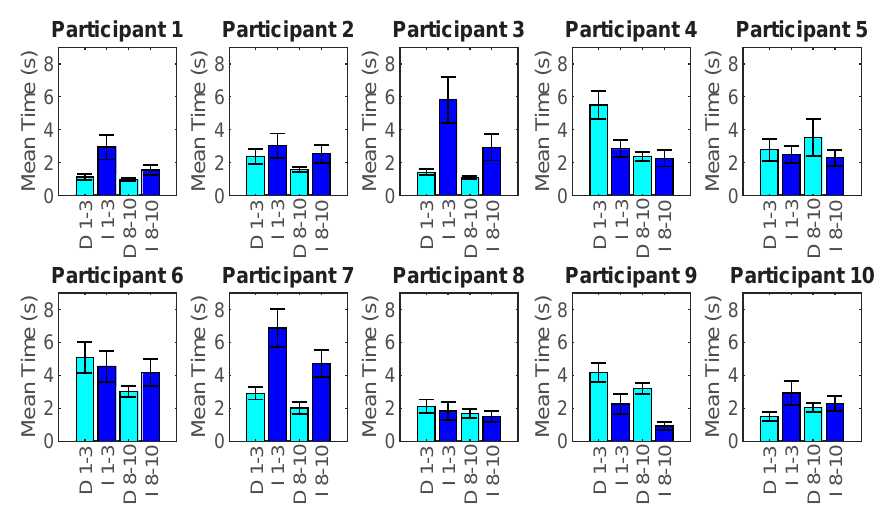
Fig 5. Mean duration of direct/indirect contralateral hand interactions for the first (1–3) and last (8–10) 3 attempts. D 1–3 = Direct interaction during attempts 1–3, I 1–3 = Indirect interaction during attempts 1–3, D 8–10 = Direct interaction during attempts 8–10, I 8–10 = Indirect interaction during attempts 8–10. Error bars show the standard error. The grand mean time spent using the contralateral hand to indirectly interact with the pros- thesis, by using the object to operate the prosthesis mechanism, reduced significantly with practice from 3.56 ± 1.65s to 2.53 ± 1.18s (t(9) = 3.666, p = 0.005, d = 1.16). The grand mean time spent using the contralateral hand to directly interact with the prosthesis did not change significantly (p = 0.072) between the first 3 attempts (2.90 ± 1.54s) and the last 3 attempts (2.16 ± 0.87s).